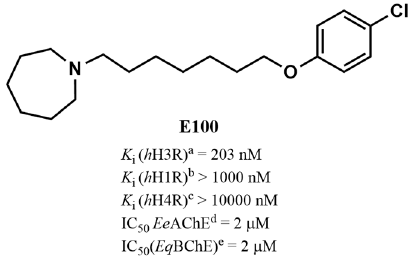
Figure 1. Chemical structure of the dual-acting human H3R ( h H3R) antagonist and AChE inhibitor E100 and in vitro data with regard to h H1-, h H3-, and h H4R, Ee AChE, and Eq BuChE. a,b,c Binding assays to determine a ffi nity to H1-, H3-, and H4Rs were performed in di ff erently expressed cells as previously described n = 3 [59]. d AChE: Acetylcholine esterase; Ee ; electric eel; e BuChE: Butyrylcholinesterase; Eq : equine